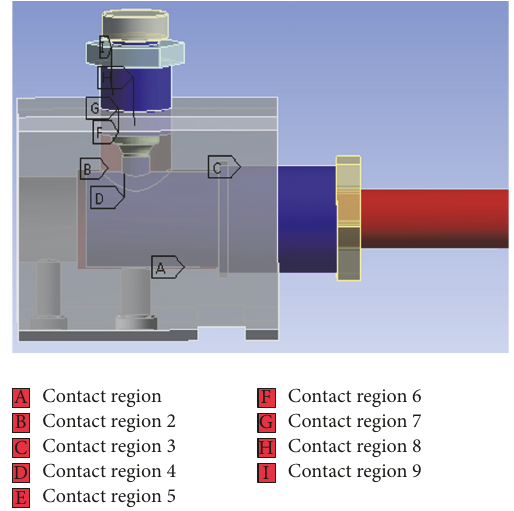
Figure 15: Applied pressure on copper